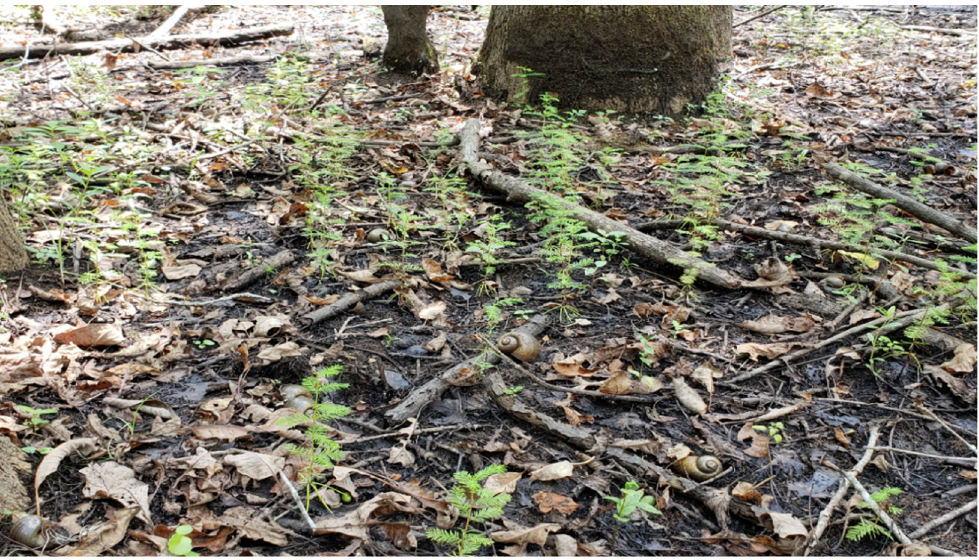
Figure 13. Seedling recruitment of bald cypress and water tupelo has occurred every year since project completion.